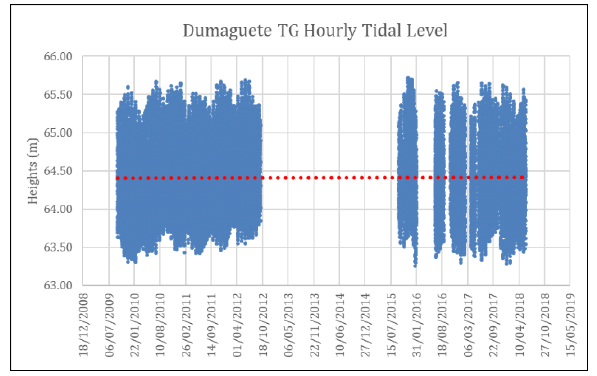
Figure 3. Dumaguete TG hourly tidal level The Mambajao TG Station with Station ID 2174 in the PSMSL